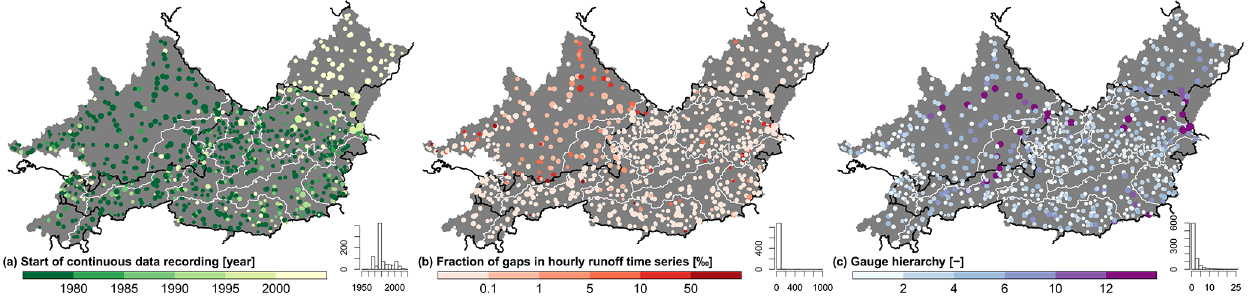
Figure 3. Maps showing a selection of gauge-referenced attributes. The size of the circles is proportional to the respective catchment area. The histograms indicate the number of gauges (out of 859) in each category. © EuroGeographics for the administrative